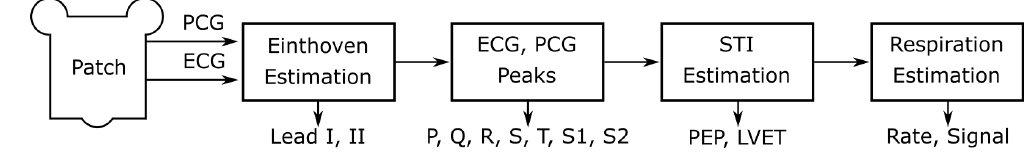
Figure 2. Overview of the processing steps and estimated modalities throughout this